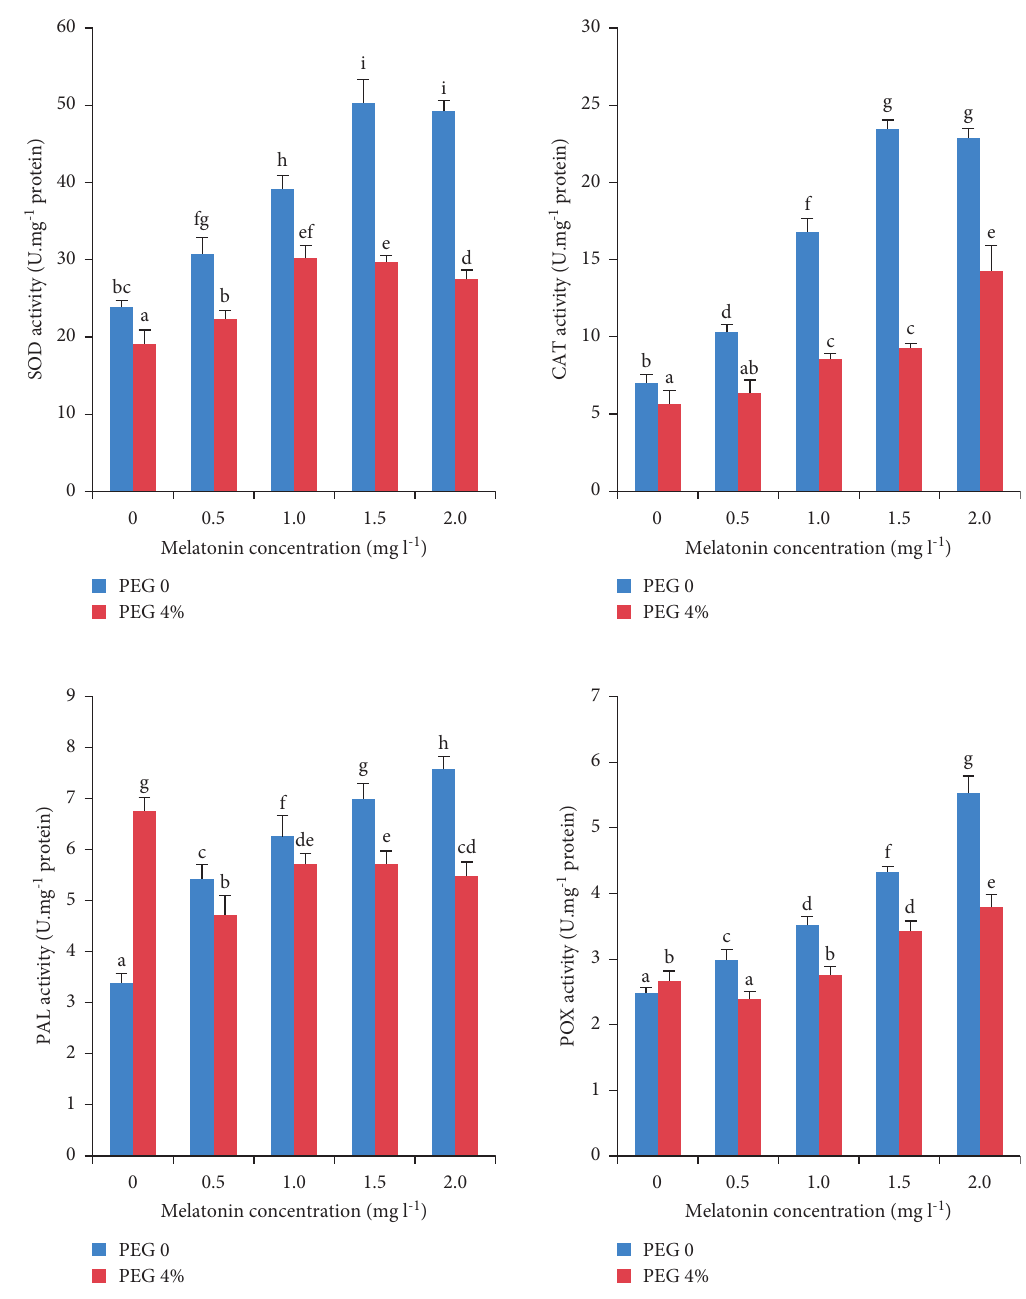
Figure 3: SOD, CAT, PAL and POX activity in H. pusillus calli cultures treated with melatonin concentrations and PEG levels after 28 days. Vertical bars indicate the standard errors of triplicates. Different alphabets indicate significant statistical differences between the mean values based on Duncan’s test at P ≤